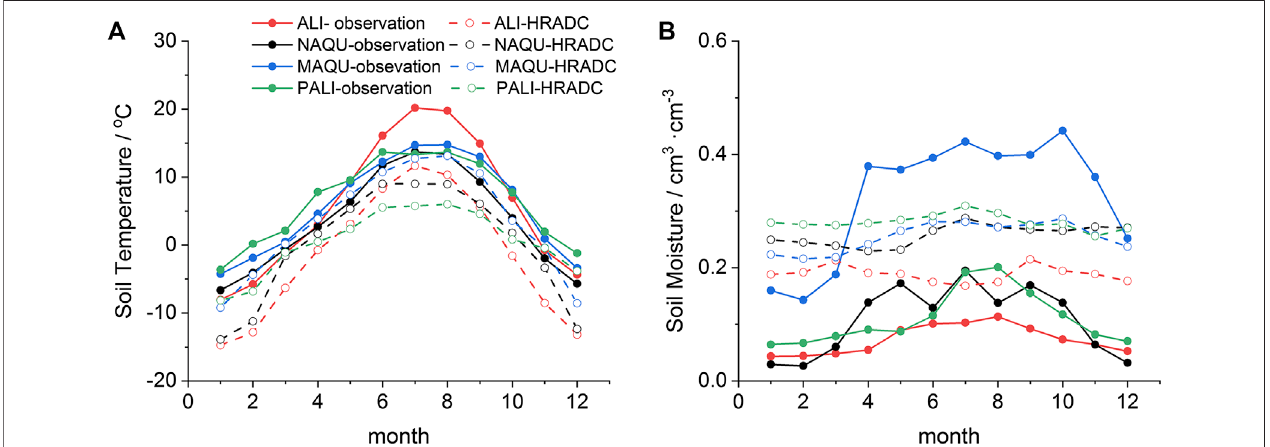
FIGURE 6 | Comparison of monthly averaged observations and High-Resolution Assimilation Dataset of the Water-Energy Cycle in China simulations, from four observation stations in Qinghai-Tibet Plateau, (A) soil temperature ( ° C) and (B) soil moisture (cm 3 · cm − 3 ) from 2010 – 2012.